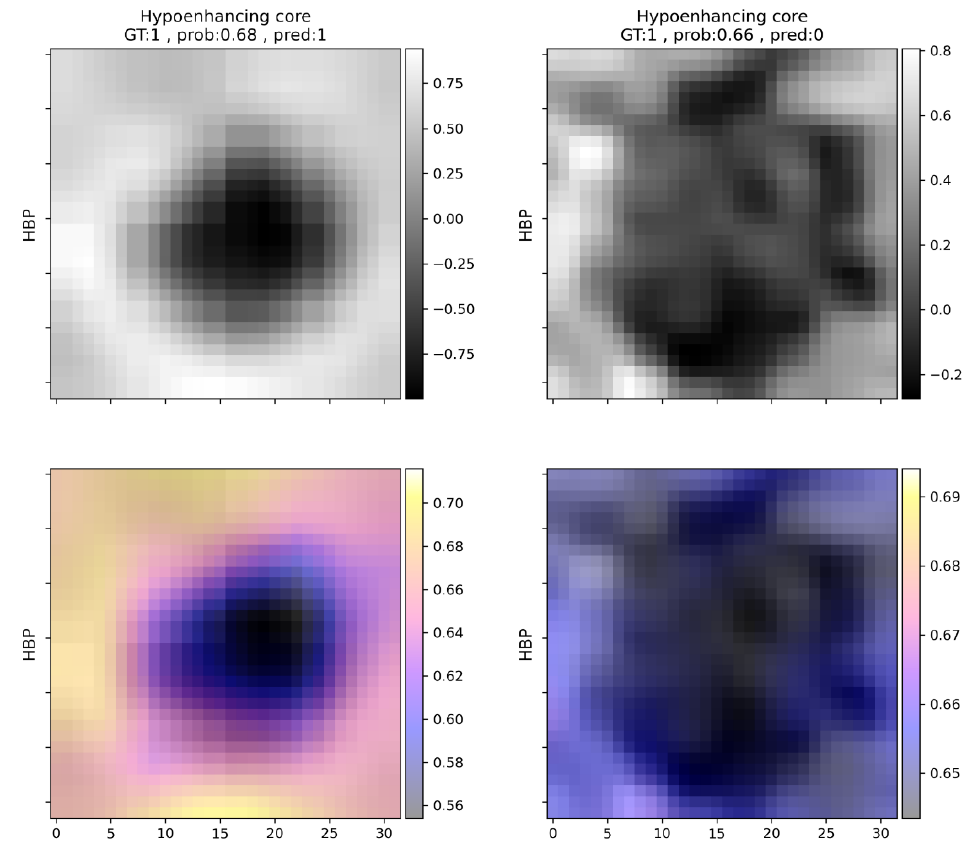
Figure 4. Examples of hypoenhancing core predictions in liver metastasis ( left ) and hepatocellular